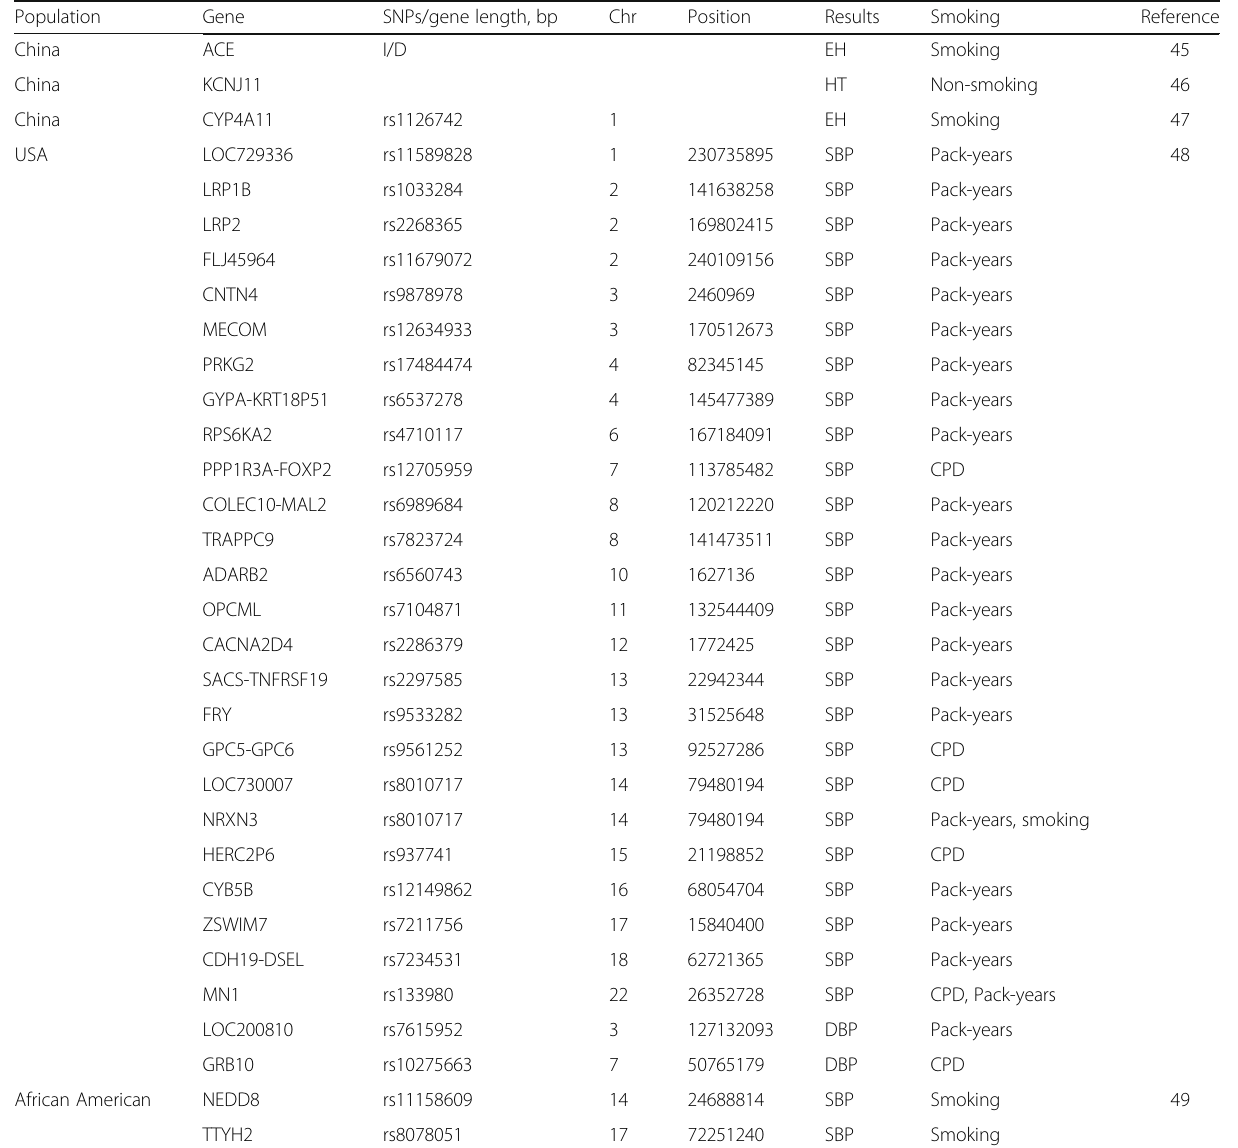
Table 5 Review for interaction of gene and smoking on hypertension